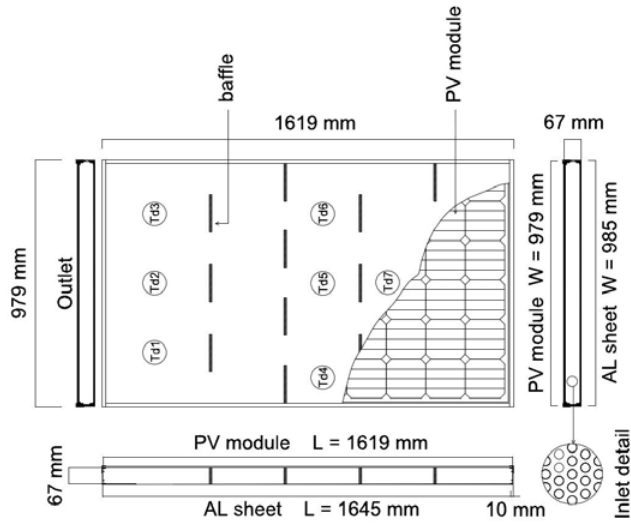
Figure 1. Detailed view of the air-type photovoltaic thermal (PVT) collector.